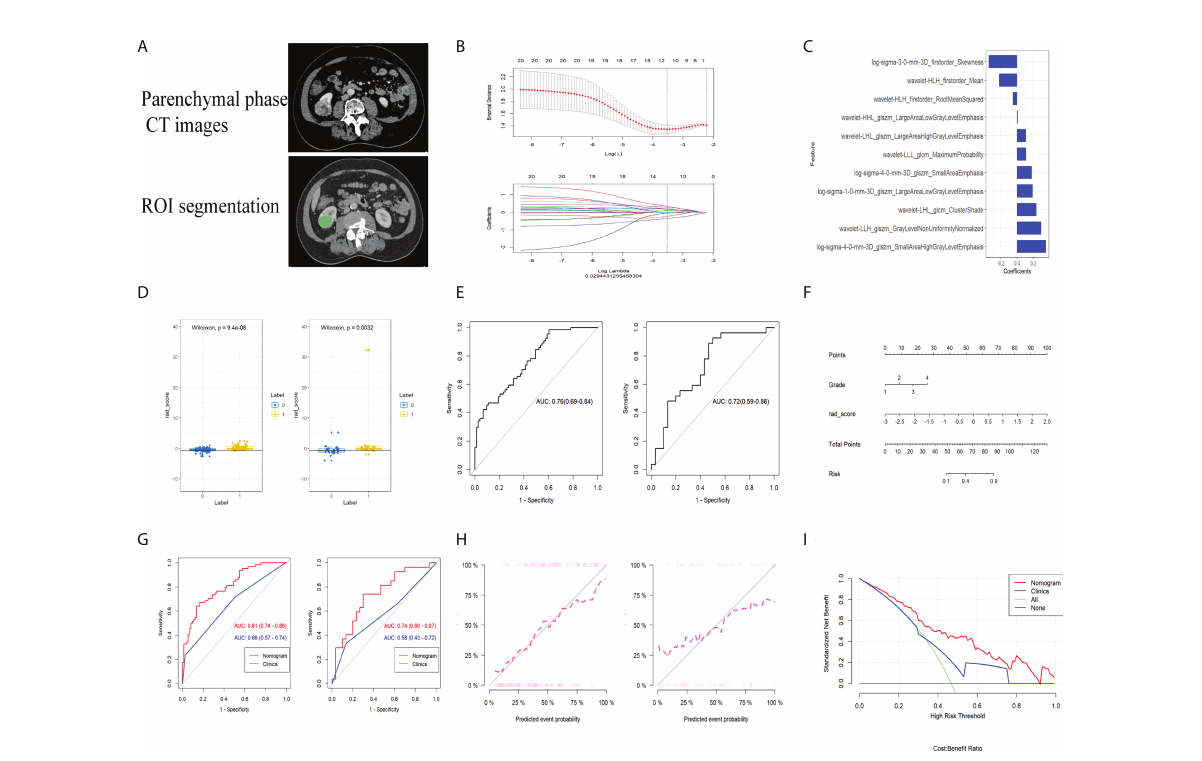
FIGURE 6 (A) CT image phase selection and ROI segmentation. (B) LASSO regression applied in the radiomics feature screening process. (C) The radiomics features fi nally screened for building the radiogenomics model. (D) M-W test showing that the radiomics model can effectively distinguish between the established gene subsets in both the training and validation groups. (E) ROC curves of the predictive power of the pure radiomics model for gene subsets in both the training and validation groups. (F) Nomogram built by combining radiomics as well as clinical and pathological information. (G) Predictive performance of the nomogram in both training and validation groups. (H) Calibration curves showing excellent fi tting ability of the established radiogenomics model. (I) DCA curves of the established radiogenomics nomogram compared with the clinical